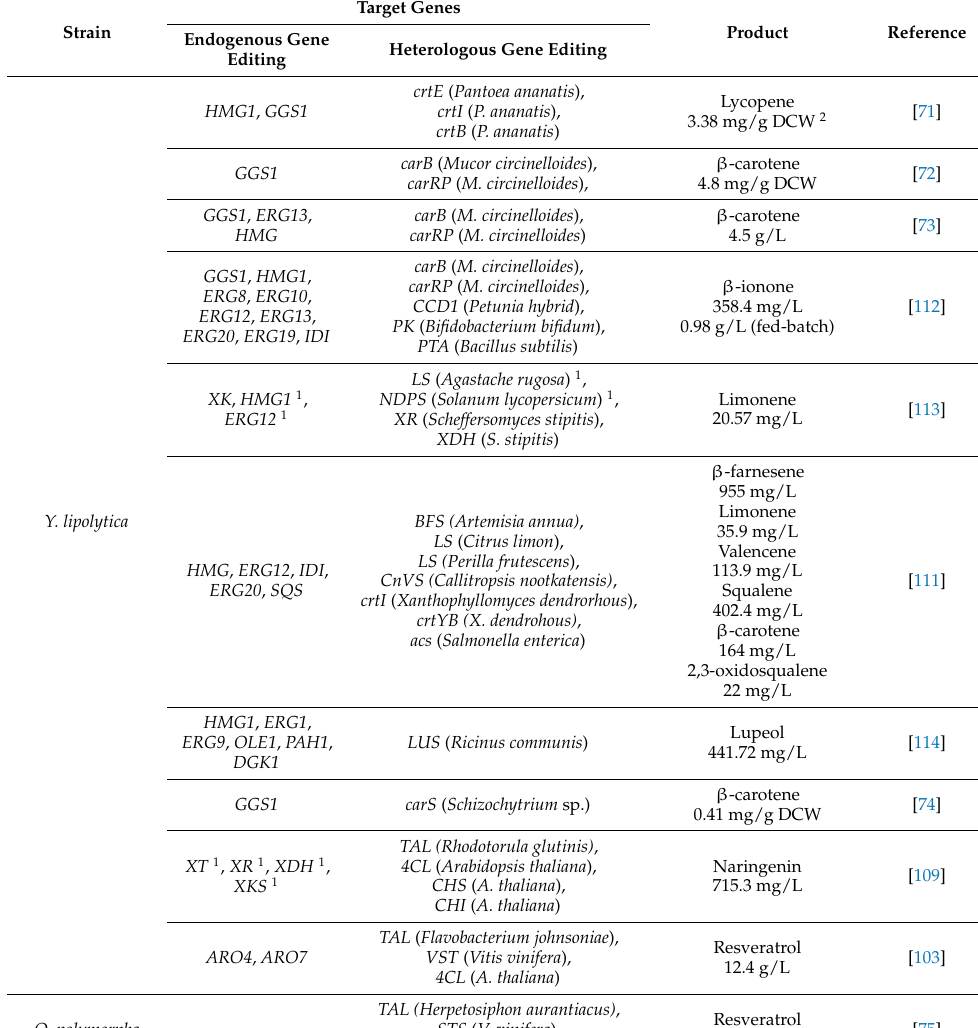
Table 2. Production of secondary plant metabolites using CRISPR-Cas9 in